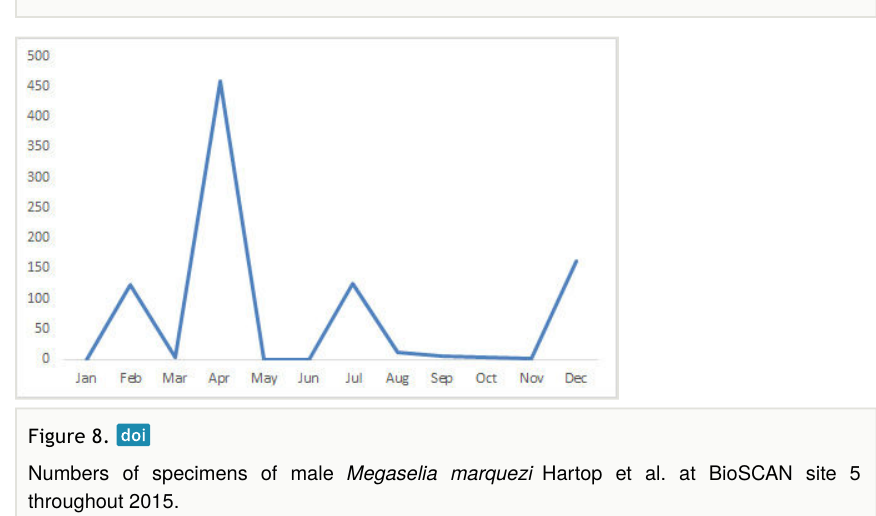
Numbers of specimens of male Megaselia marquezi Hartop et al. at BioSCAN site 5 throughout